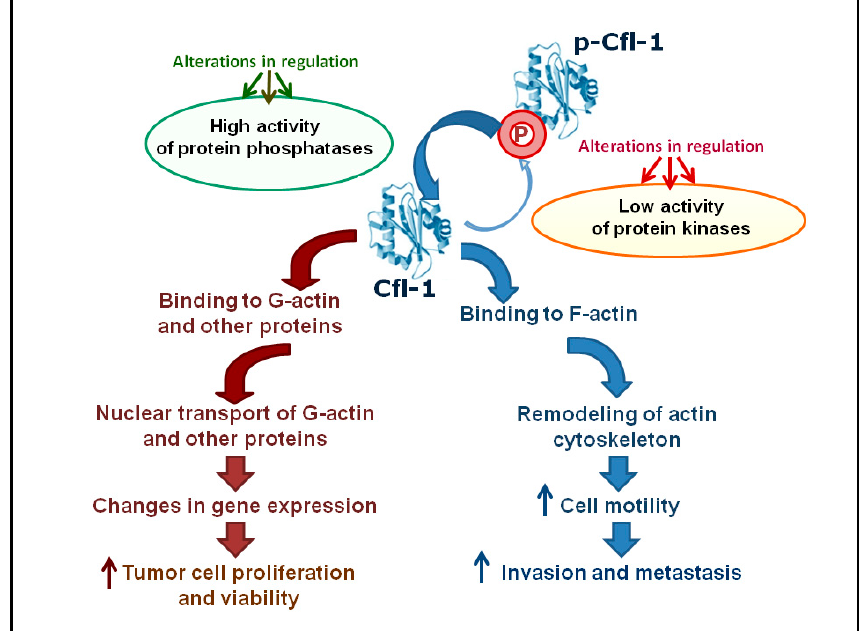
Figure 5. Simplified scheme showing changes in Cfl-1 functions in HMCs. This scheme does not consider, for example, the possible positive role of LIMK1 overexpression in invasion and metastasis. Alterations in regulation (green) and alterations in regulation (red) refer to changes in signaling pathways that lead to increased Cfl-1 dephosphorylation (activation) or decreased phosphorylation (inactivation), respectively.